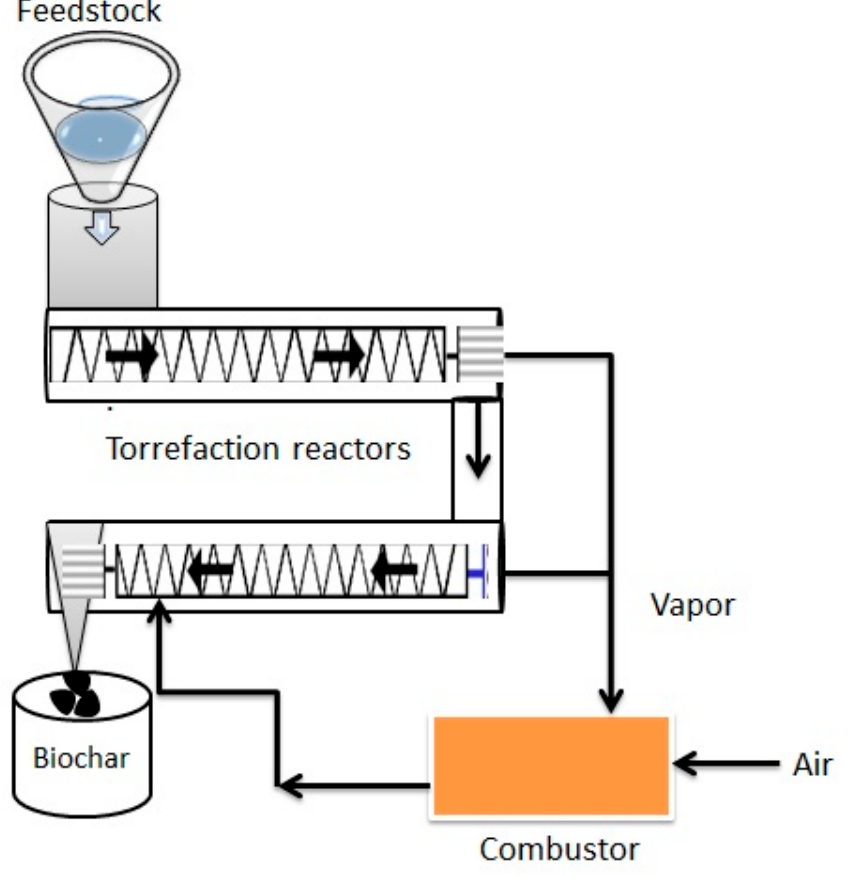
Figure 5. Simple illustration of torrefaction process. Table 1. Average ranges for the process conditions in biochar production technologies most used at present, including slow and fast pyrolysis, gasification, and torrefaction, and yield of the main products for each technology